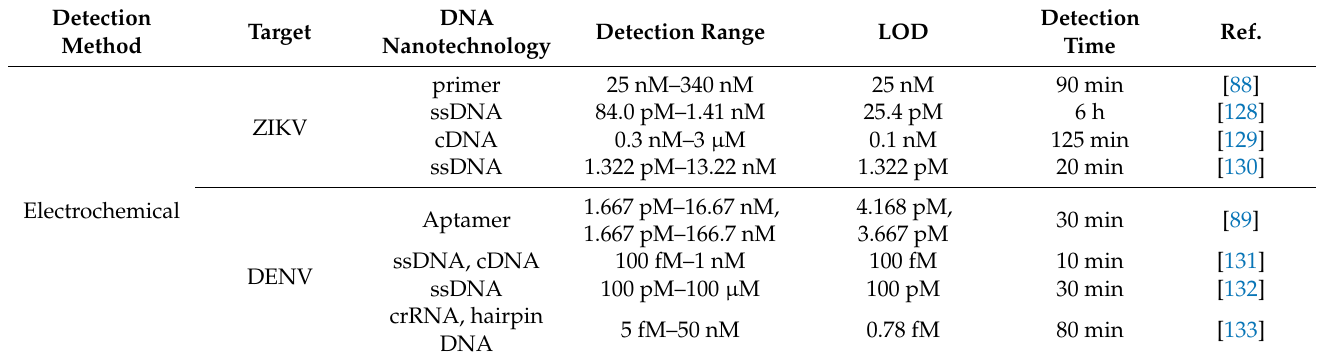
Table 1. ZIKV and DENV detection biosensors based on DNA